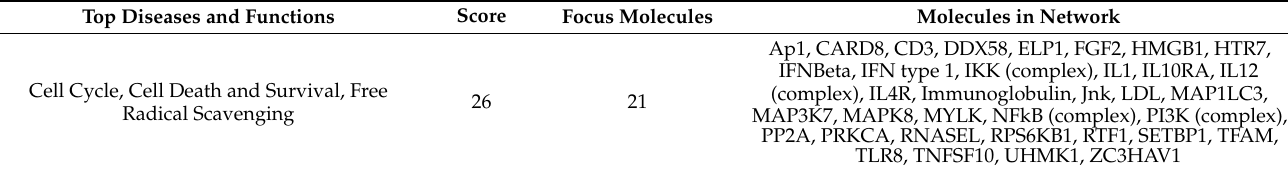
Table 3. Network analysis of the predicted target genes of miR-545-3p according to the IPA database. Top Diseases and